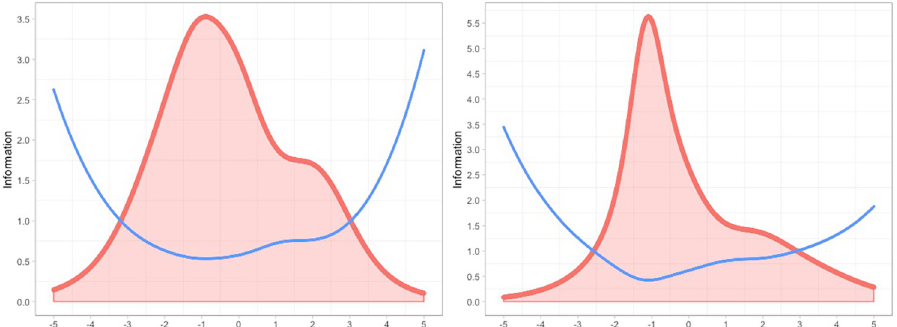
Fig 3. Test Information function for sample 1 (left) and sample 2 (right). Note. The x-axis indicates the latent trait (“Social support”) and the y-axis indicates the information. The red line with shaded area represents the Test Information Function and the blue line represents the Standard Error of Measurement